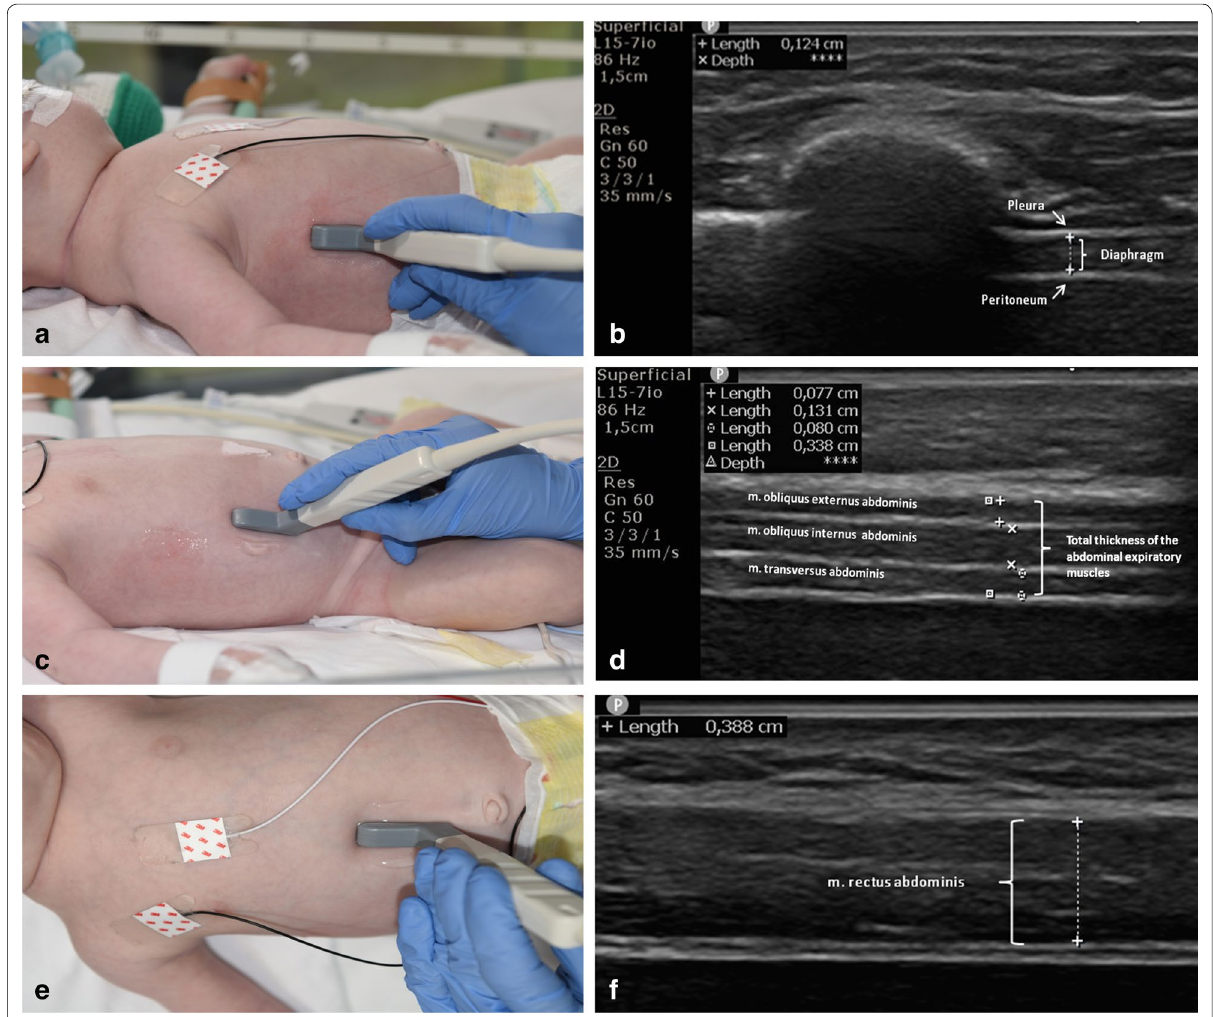
Fig. 1 Ultrasound position and measurements of diaphragmatic thickness in the zone of apposition ( a , b ) of the 3 abdominal muscles (m. obliquus externus abdominis, m. obliquus internus abdominis, m. transversus abdominis), separate and together ( c , d ); and of the m. rectus abdominis ( e , f ) with a 7–15 MHz linear array transducer. Pictures were taken with the informed consent of the legal